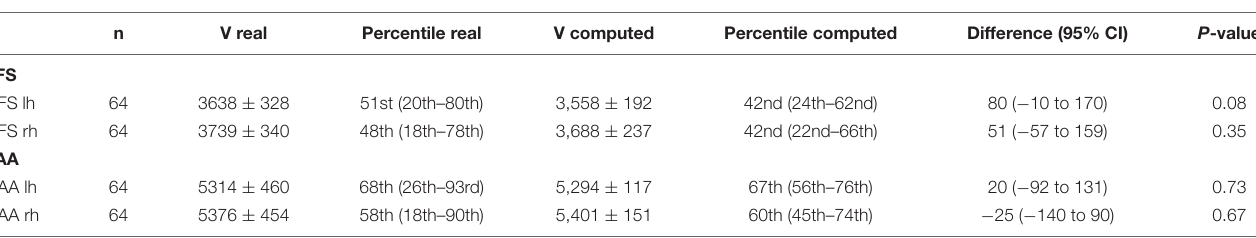
TABLE 3 | Comparison between real and computed volumes in IBNA